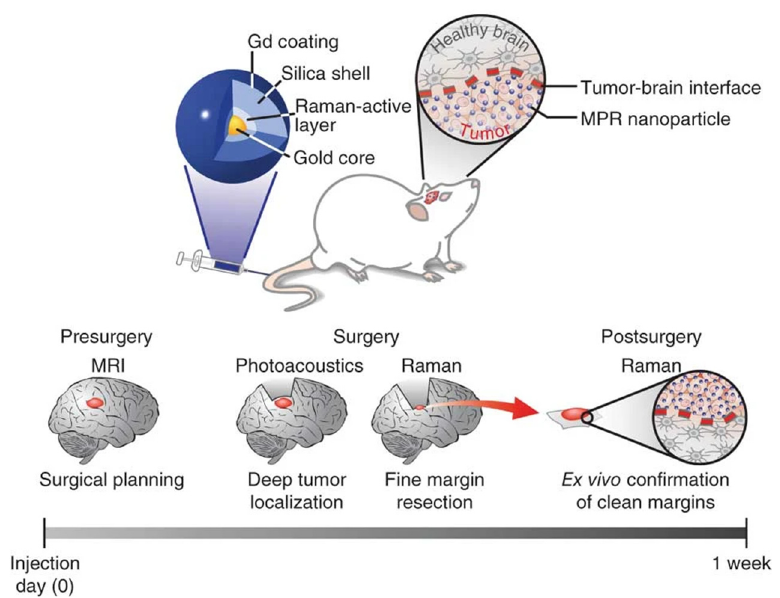
Figure 9. Imaging strategy based on MPR NPs. Gd: gadolinium. Reproduced with permission from Ref. [91]. Copyright 2016, Nature Publishing Group.